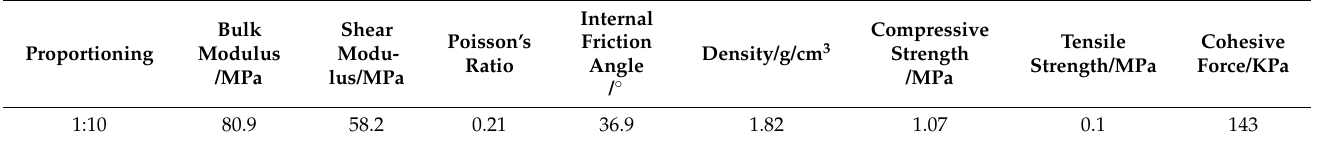
Table 4. Material parameters of backfills.